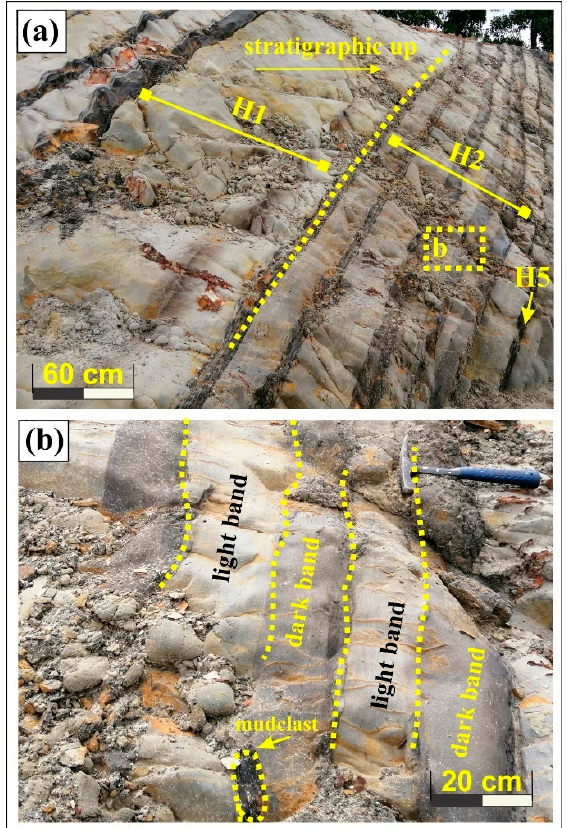
Figure 5. The development of hybrid event bed facies in proximal lobe system. ( a ) An expression of a sandy hybrid event bed (H1 and H2) from the base to the top of a sedimentary unit in the Jalan UMS (JU) section, West Sabah, at multimeter scale where the yellow dashed line indicates the facies boundary between H1 and H2. ( b ) An enlarged image of the H2 hybrid event bed facies containing lighter and darker sand intervals (yellow dashed lines representing the boundary of light and dark bands) with a floating mud clast (labelled in yellow oval ‐ shaped dashed lines) that is relatively uncommon in H2 facies and was not reported previously.